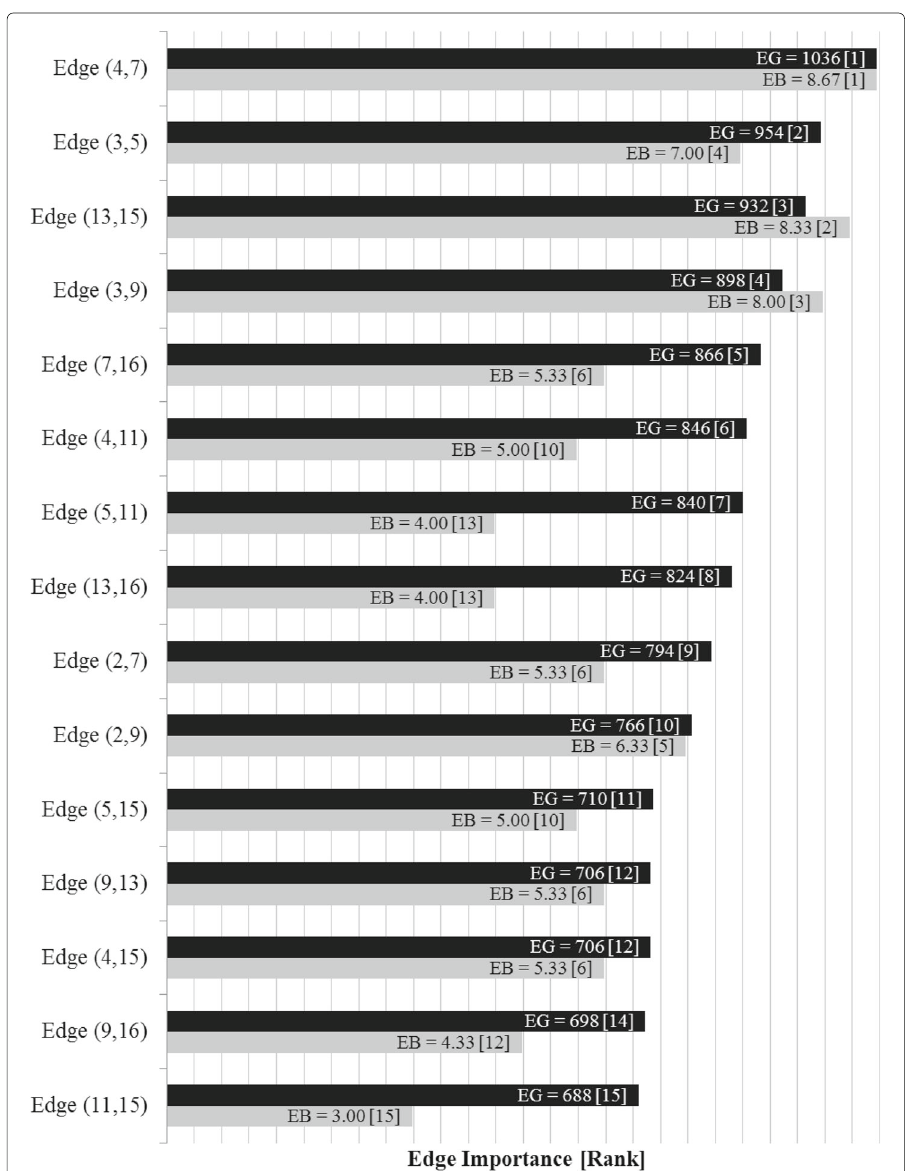
Fig. 16 Edge Gravity and Edge Betweenness solutions for the Florentine families network with bridges to nowhere removed